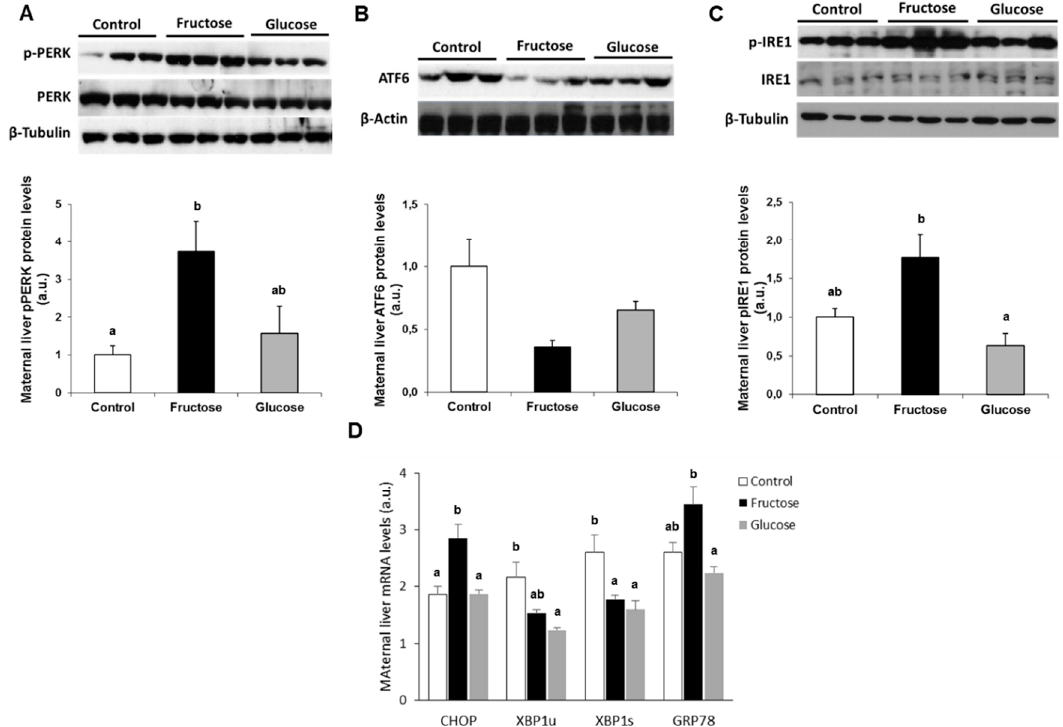
Figure 1. Maternal ingestion of a 10% w/v fructose solution throughout gestation affects maternal ER stress in the liver. Bar plots showing ( A ) the ratio between Thr-phosphorylated form, and the total protein kinase RNA-like endoplasmic reticulum kinase (PERK), ( B ) total activating transcription factor 6 (ATF6), and ( C ) the ratio between Ser-phosphorylated form and the total inositol requiring enzyme 1 (IRE1) proteins in hepatic samples of control (empty bar), fructose (black bar), and glucose-fed (grey bar) pregnant rats. The amount of protein loaded was confirmed by the Bradford method, and the uniformity of protein loading in each lane was assessed by staining the blots with Ponceau S. Values were normalized to β -actin or β -tubulin levels and expressed in arbitrary units (a.u.). ( D ) Bar plots showing the relative hepatic levels of specific mRNA for target genes controlled by the three branches of the unfolded protein response (UPR) from control, fructose, and glucose pregnant rats. Results are the mean ± S.E. of values from 6–7 rats for mRNA expression and 5 rats for protein gene expression. Small letters correspond to the statistical comparisons between rats receiving different supplementation in the drinking water. Values not sharing a common letter are significantly different at P < 0.05. CHOP: C/EBP homologous protein; XBP1u: unspliced X-box-binding protein; XBP1s: spliced X-box-binding protein; GRP78: glucose-related protein 78.